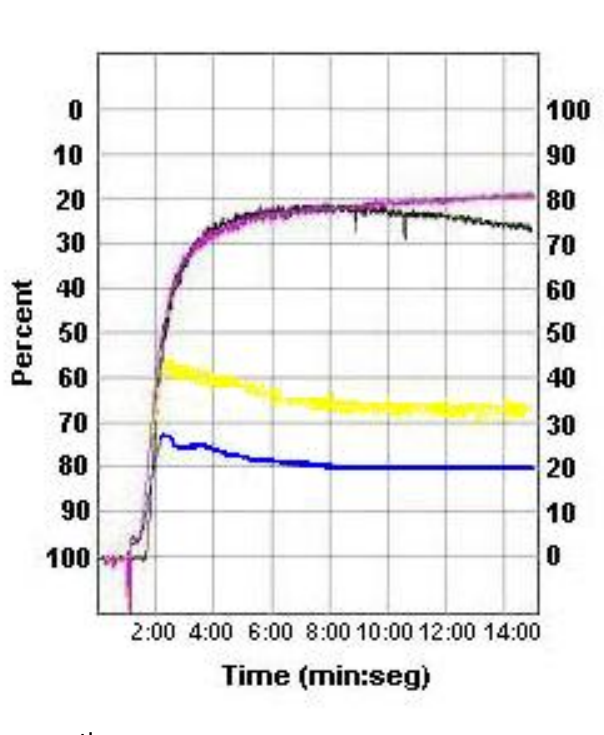
Figure 4: Platelet aggregation. Assay of platelet aggregation was carried out with human platelet rich plasma (PRP) and increasing quantity of pure crotacetin (32.8 µ g/ml, blue curve; 49.3 µ g/ml, yellow; 65.5 µ g/ml, magenta). Collagen was used as control (black curve). Aggregation response was monitored by turbidimetry and represented by percent of light transmittance (Y-axis) versus time, in minutes